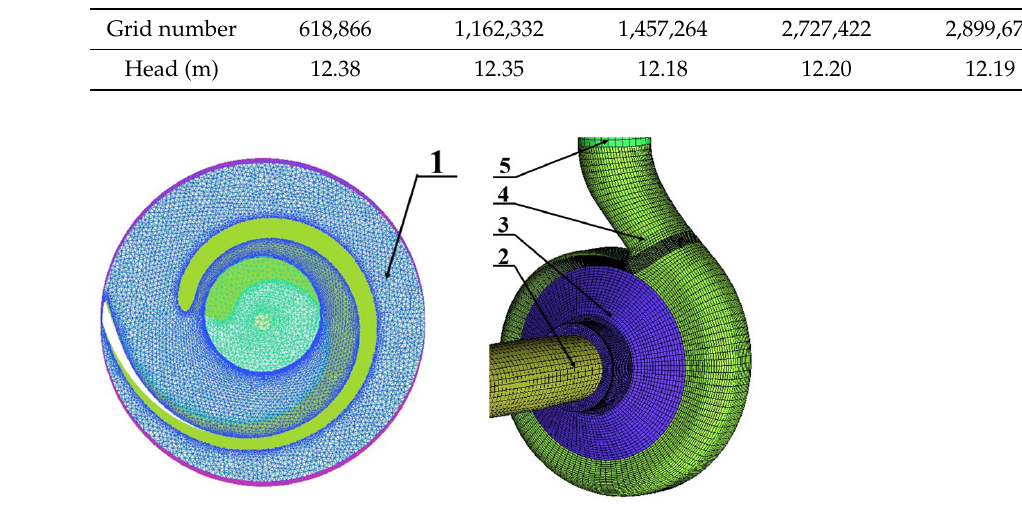
Figure 2. Mesh of the pump. 1. Impeller, 2. Inlet, 3. Chamber, 4. Volute, 5. Outlet. Table 1. Head of the pump at different grid number.